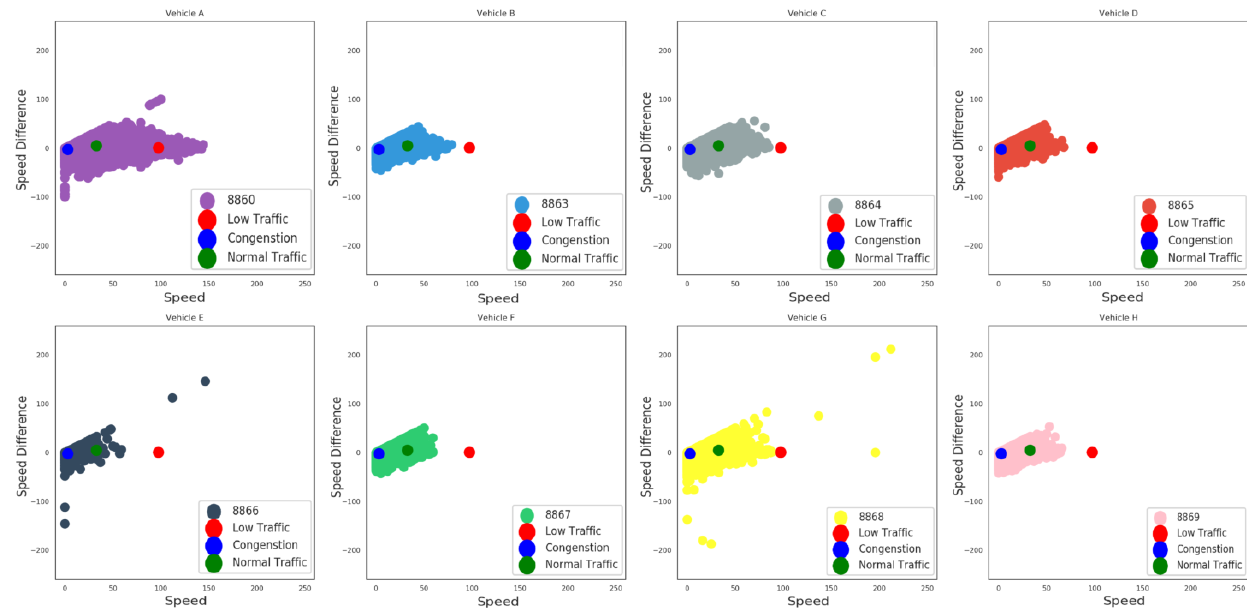
Figure 8. Data samples of each vehicle connected with the clustering centroids.